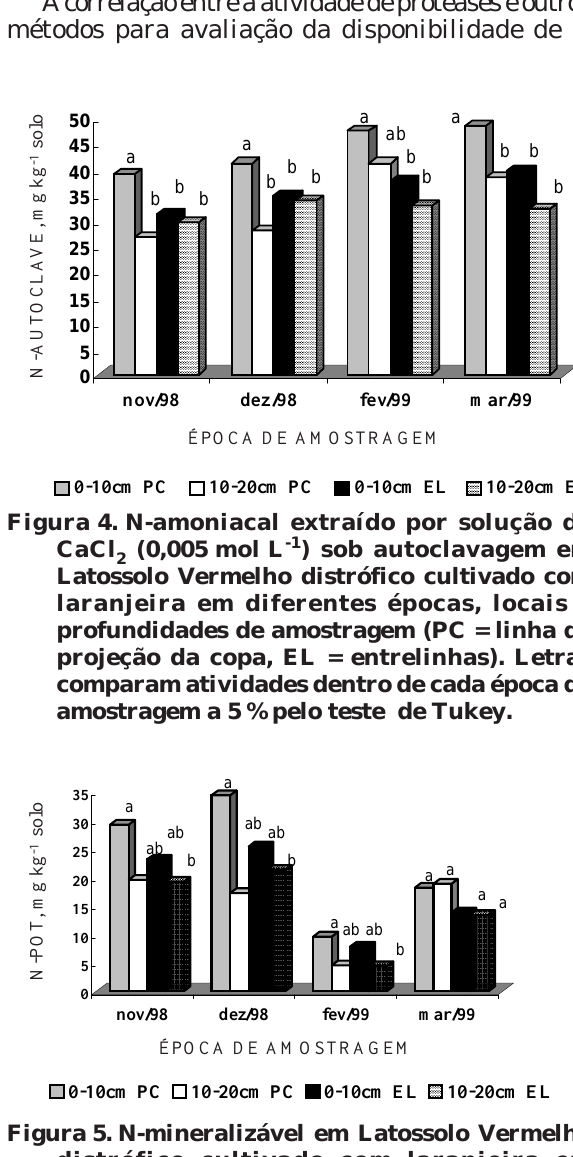
Figura 5. N-mineralizável em Latossolo Vermelho distrófico cultivado com laranjeira em diferentes épocas, locais e profundidades de amostragem (PC = linha de projeção da copa, EL = entrelinhas). Letras comparam atividades dentro de cada época de amostragem a 5 % pelo teste de